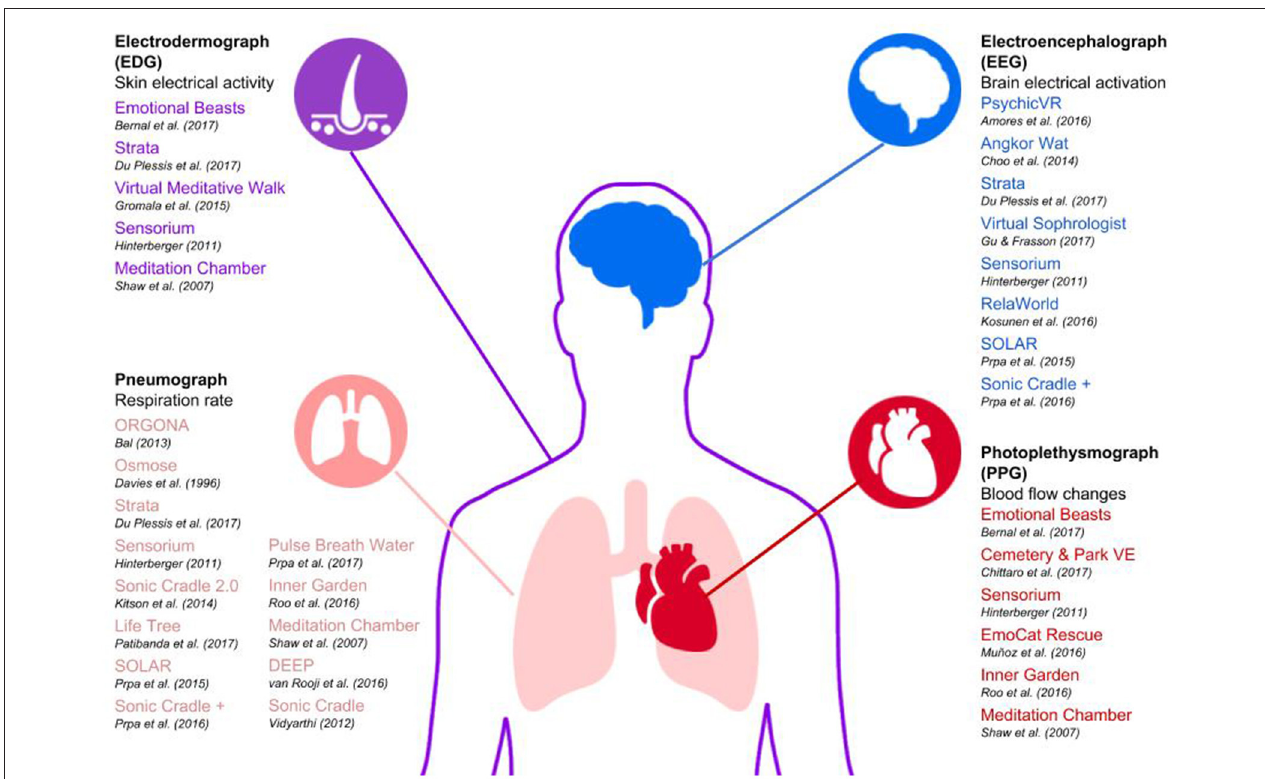
FIGURE 4 | Biofeedback types and their corresponding immersive, interactive experiences. There are four types of biofeedback represented: electrodermograph (EDG), pneumograph (respiration rate), electroencephalograph (EEG), and photoplethysmograph (PPG). The names of the experience along with the author’s name is listed. Some experiences are listed multiple times, indicating they used multiple types of biofeedback in their